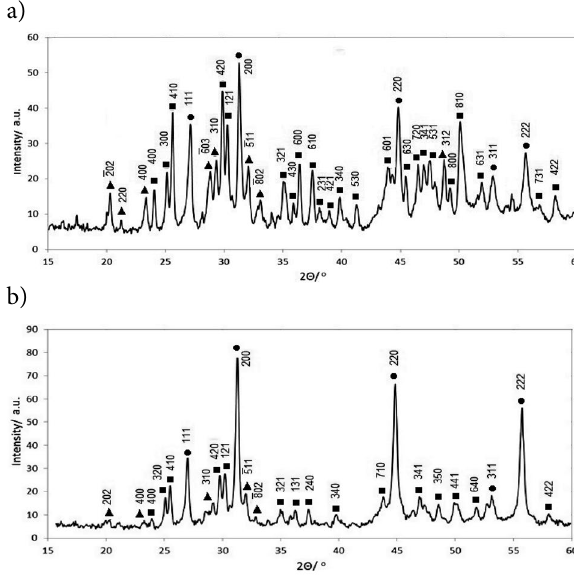
Figure 4. XRD patterns of the alloys of the polythermal section